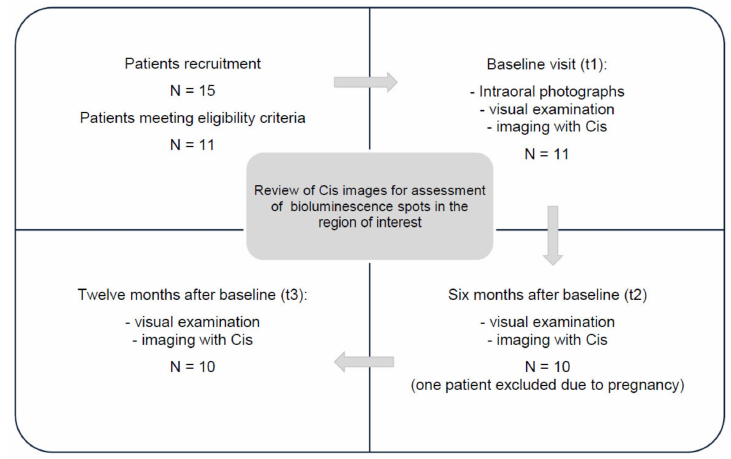
Figure 1. Outline of the study